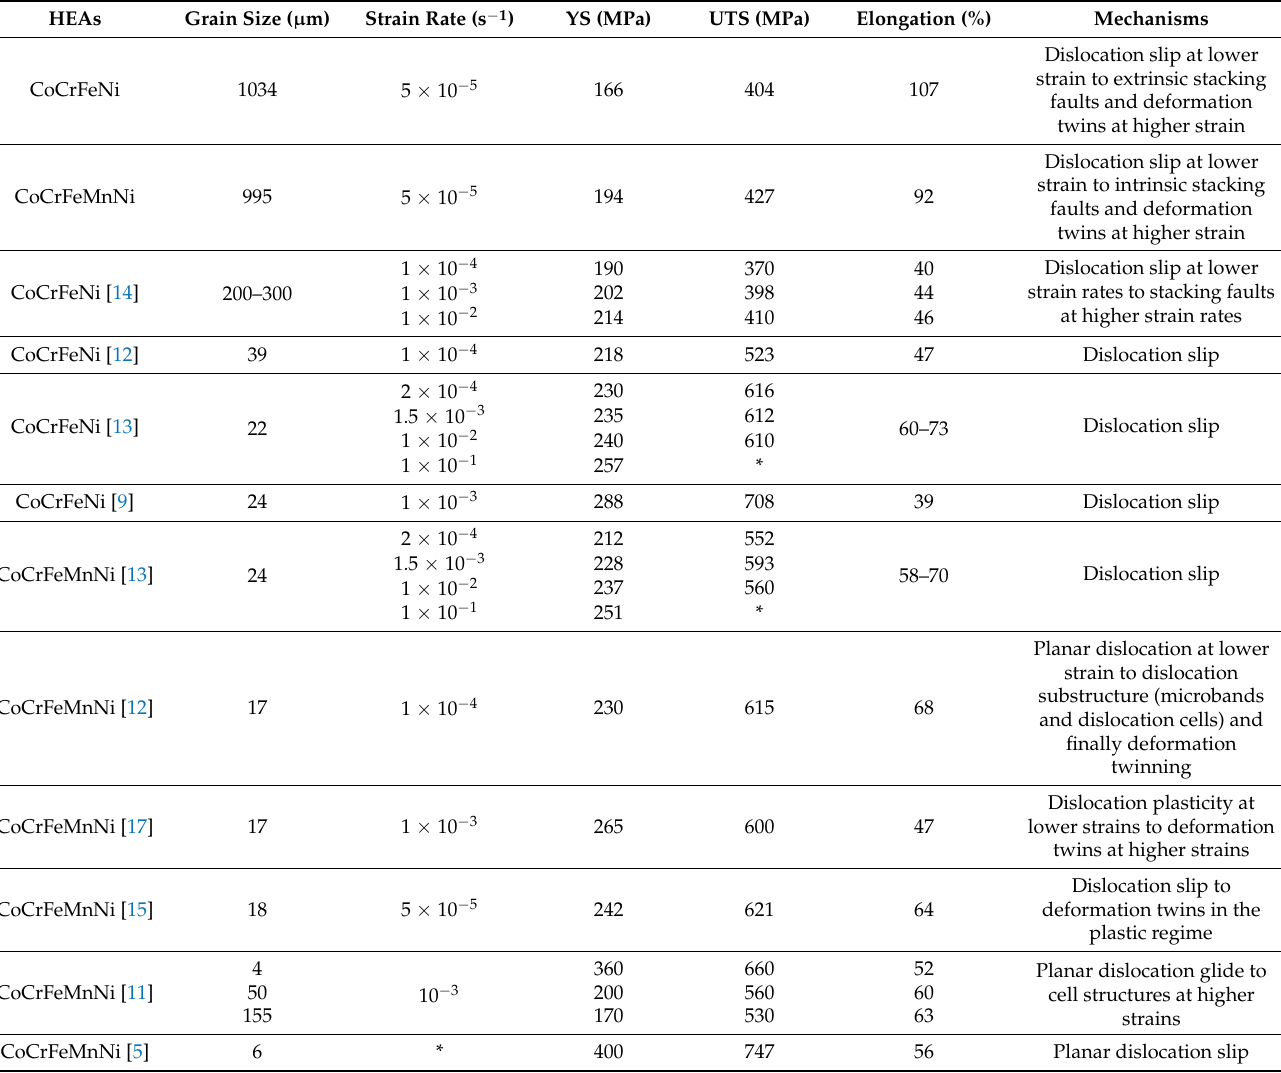
Table 1. Summary of the tensile properties of CoCrFeNi and CoCrFeMnNi HEAs with different grain sizes and strain rates at room